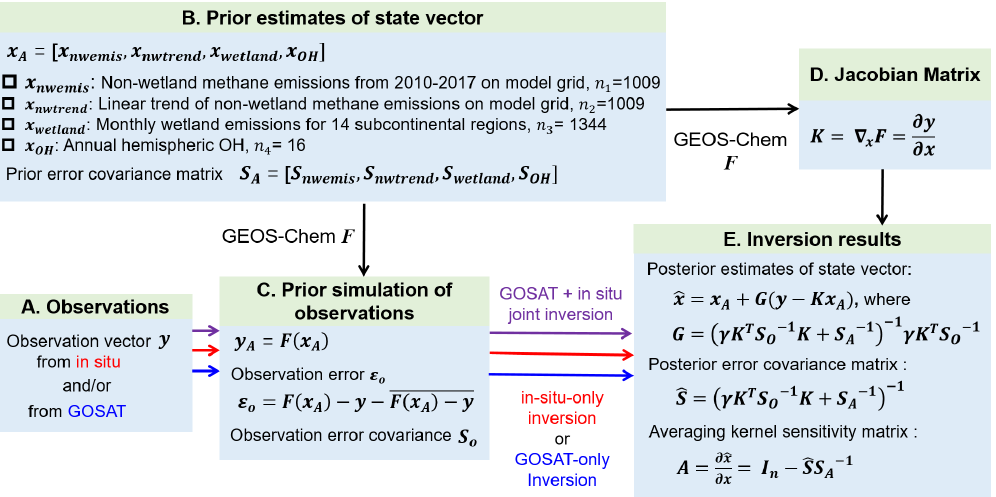
Figure 1. Analytical inversion framework. The inversion is applied to GOSAT and GLOBALVIEWplus in situ observations for 2010–2017. GEOS-Chem is the chemical transport model (CTM) used as the forward model for the inversion. γ is a regularization factor in the Bayesian cost function (see text).